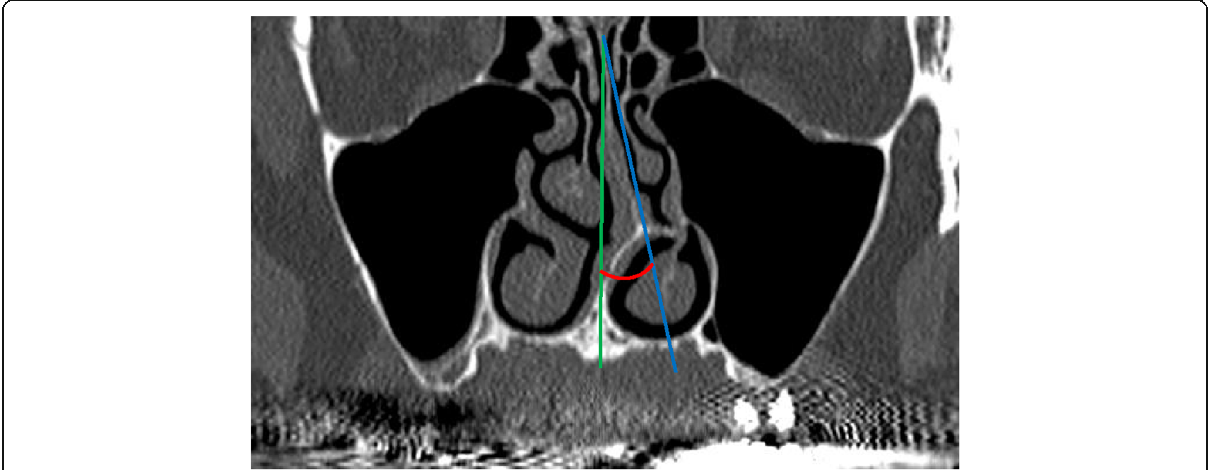
Fig. 2 Measurement of nasal septum deviation. The angle between the anterior nasal spine from the crista galli (green line) and the line connecting the most prominent point of the nasal septum from the crista galli (blue line) represents the nasal septum deviation